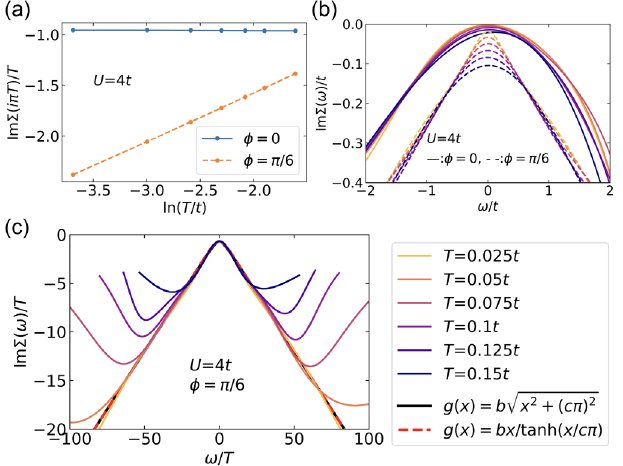
FIG. 5. Resistivity from paramagnetic DMFT solution at ¼ i π T; T Þ =T as a function of ln ð T=t Þ at the .FIG. 4. (a) Im Σ ð i ω n U=t ¼ 4 , 8 for ϕ ¼ 0 ; π = 6 for different carrier concentrations, first Matsubara frequency point. (b) The imaginary part of the shown in the legend. The inset in (c) shows resistivity data (solid self-energy Im ½ Σ ð ω Þ(cid:3) for ϕ ¼ 0 and π = 6 at U ¼ 4 t and half line) and dashed curves calculated by a simple formula ρ ¼ filling. (c) Im ½ Σ ð ω Þ(cid:3) =T versus ω =T for ϕ ¼ π = 6 . The black and ffiffiffiffiffiffiffiffiffiffiffiffiffiffiffiffiffiffiffiffiffi p ð 6 . 5 T 2 Þ = ð T þ T ⋆ Þ with the crossover scale T ⋆ ¼ 6 t ð 1 − n Þ 2 x 2 þ ð c π Þ 2 red lines are reference lines g ð x Þ ¼ b and g ð x Þ ¼ bx= tanh ½ x= ð c π Þ(cid:3) , correspondingly. The slope b ≈ 0 . 24 is obtained independently from the fitting shown in (a), and c ≈ 0 . 92 is obtained from the linear fitting of Im ½ Σ ð ω ¼ 0 Þ(cid:3)